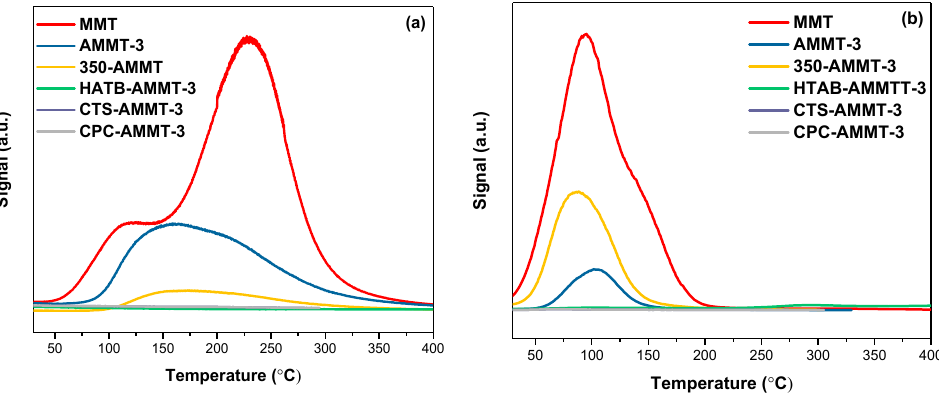
Figure 3. Profiles of acetone-TPD ( a ) and benzene-TPD ( b ) of raw MMT and modified montmoril- lonites